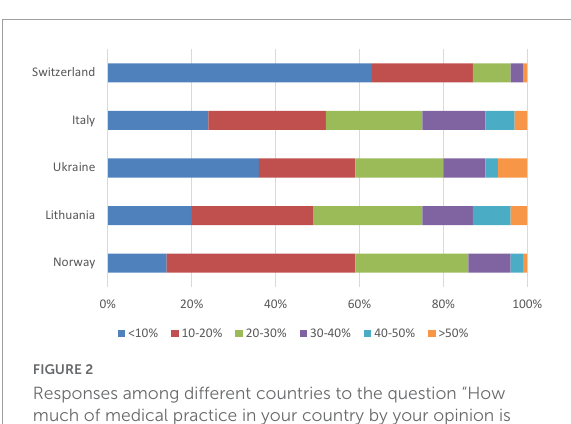
overactivity than colleagues > 50 years (adjusted odds ratio 0.58, 95% CI 0.43–0.79) ( Table 2 ), while the opinions were similar in males and females. The predictors for “overtreating yourself” were very similar as for the first question of “medical overuse in your country” (data not